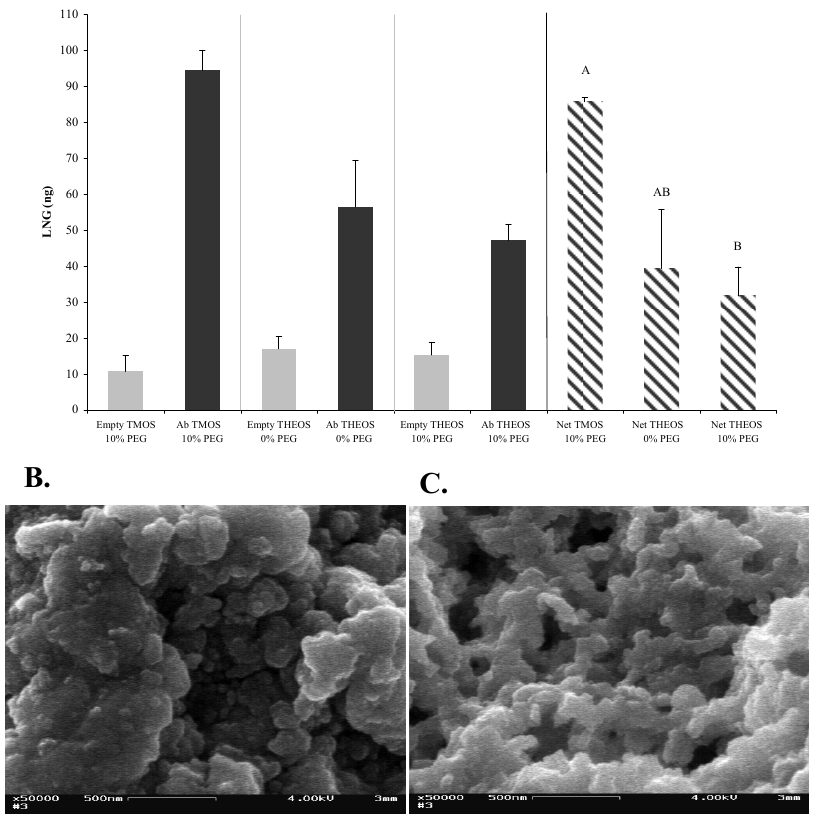
Figure 4. Effects of different monomers on the structure of the sol-gel and on the activity of entrapped Abs. ( A ) LNG (100 ng) was applied on 1-day-aged sol-gel columns prepared with TMOS or THEOS as precursor, at a precursor:HCl ratio of 1:8, with 10% of 0.4 kDa PEG. Amounts of eluted LNG were determined by ELISA. Each vertical bar represents the mean  S.E.M of two experiments. Means with the same letter did not differ significantly at p < 0.05; ( B ) and ( C ) are SEM images of freshly prepared sol-gels based on 1:8 THEOS and 1:8 TMOS, respectively, containing 10% of 0.4-kDa PEG. All other details are as described in the legend to Figure 2. Magnification × 50,000; scale bar represents 500